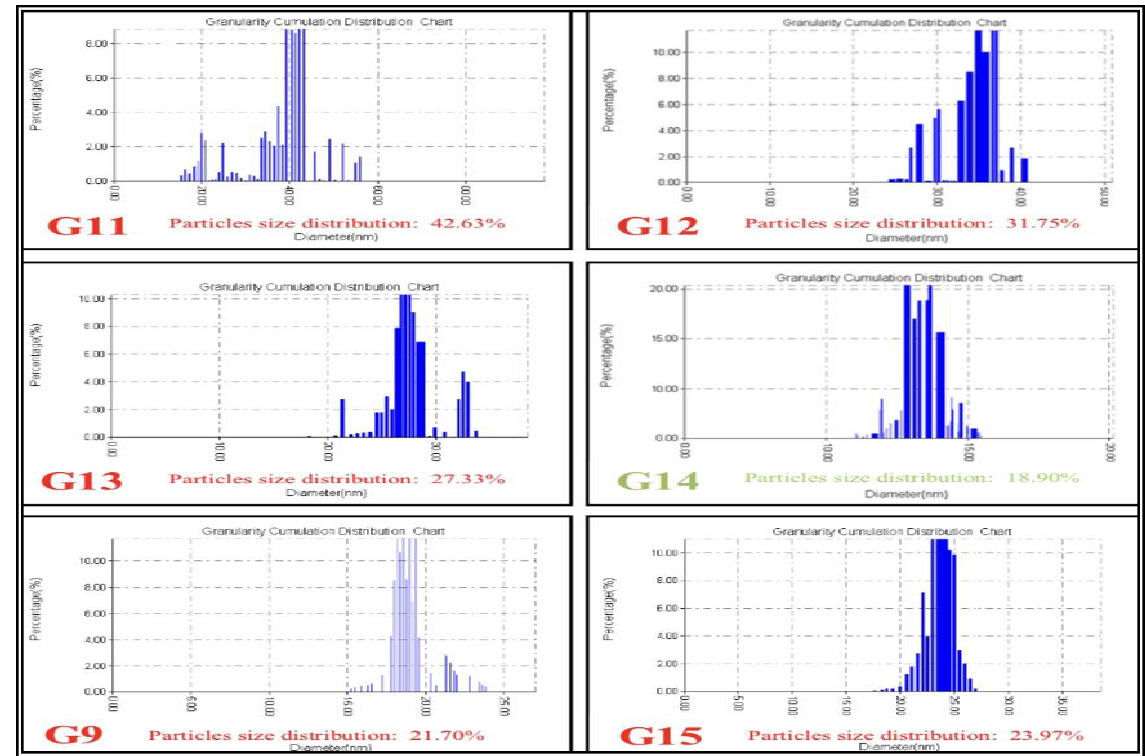
Figure 10. AFM size distribution of gold nanoparticles G9, G11-15 Effect of stirring rate